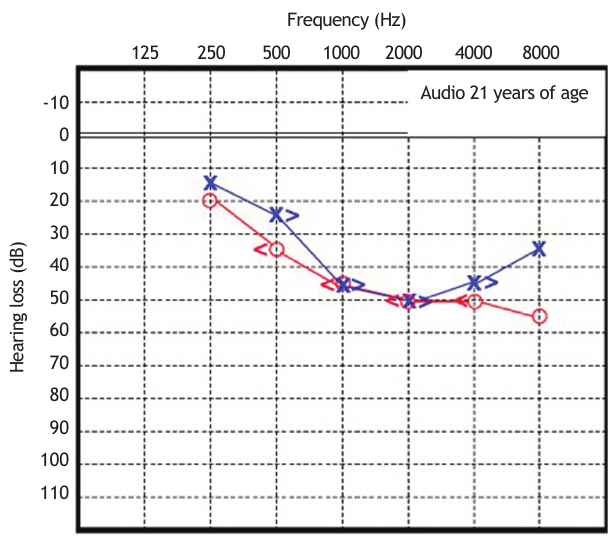
Figure 3 Audiometry in patient 1, performed at 21 years of age.